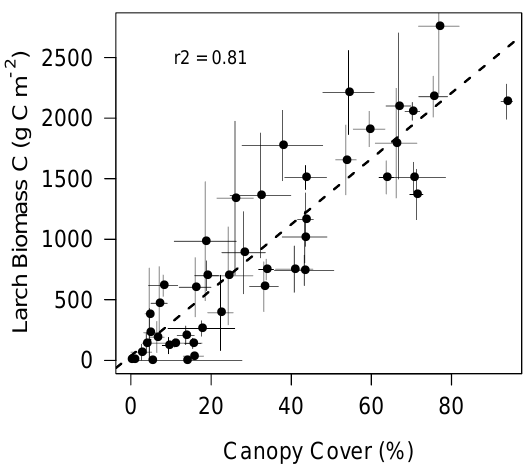
Figure 3. Linear relationship between canopy cover and aboveground larch biomass carbon for 46 stands sampled across an upland landscape. Whiskers indicate standard error of the mean (SE).